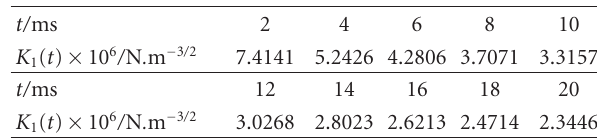
Table 1: Relevant numerical values between dynamic stress inten- sity factor K 1 ( t ) and time t .